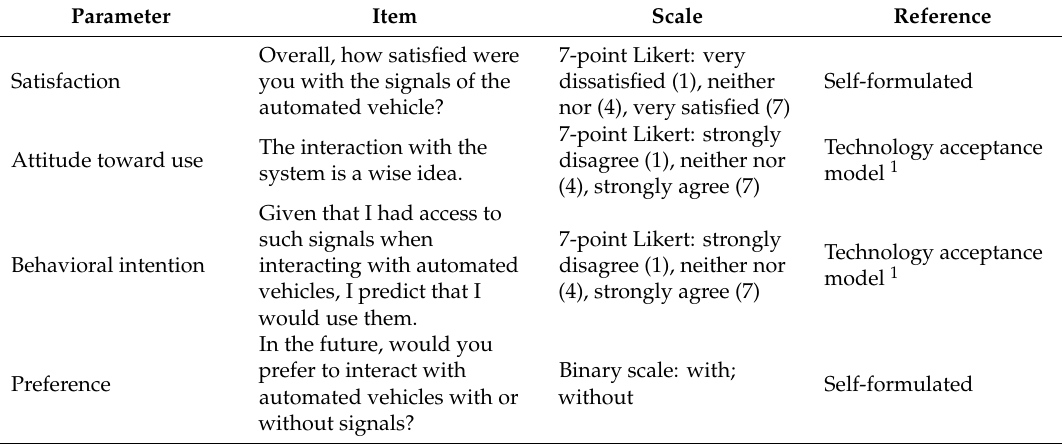
Table 2. Parameters and items to assess the satisfaction with an